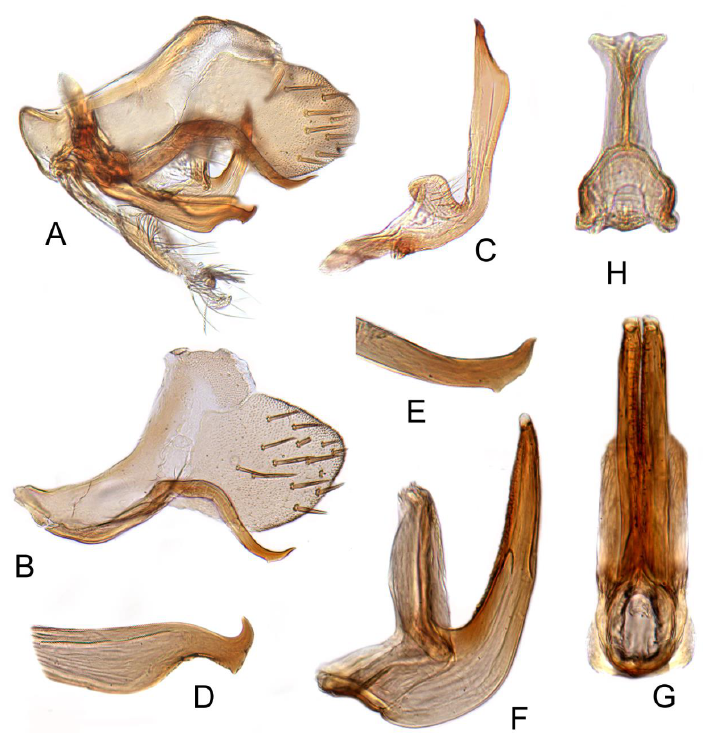
Figure 8. Batracomorphus juno Knight, 1983: ( A ) genital capsule in lateral view; ( B ) pygofer side and pygophore processes; ( C ) styles; ( D ) styles apex; ( E ) pygophore processes apex; ( F ) aedeagus, lateral view; ( G ) aedeagus, ventral view; ( H ) connective. 3.3.4. Batracomorphus juno Knight, 1983 rec. nov. Figures 3A – C and 8A – G Batracomorphus juno Knight, 1983: 125, figs. 493 – 503 [8]. Description. Male 3.9 – 4.7 mm long, 0.9 – 1.0 mm wide across eyes, 1.6 – 2.0 mm wide across hind margin of pronotum. Colour yellowish green. Forewings with distinctive fine setae and punctation black; appendix at base fuscous. Pygofer side round apically, with many macrosetae near posterior margin, inner pro- cess slender, sinuate posteriorly, apex acute, curved posterodorsally, ventral margin